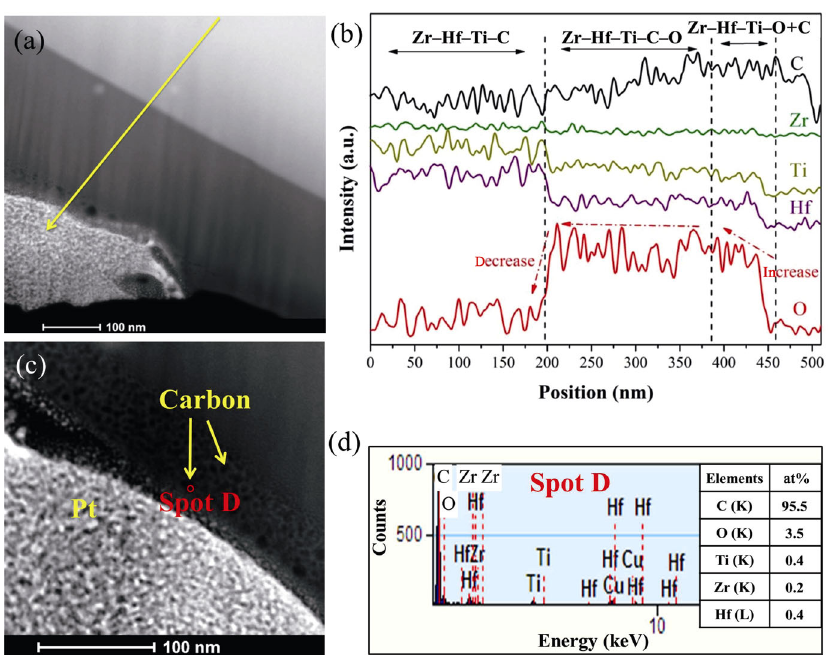
Fig. 11 EDS analysis of Zr 1/3 Hf 1/3 Ti 1/3 C 0.8 after being oxidized at 500 ℃ : (a, c) HAADF–STEM images, (b) element scanning along the line position in (a), and (d) EDS analysis of Spot D in